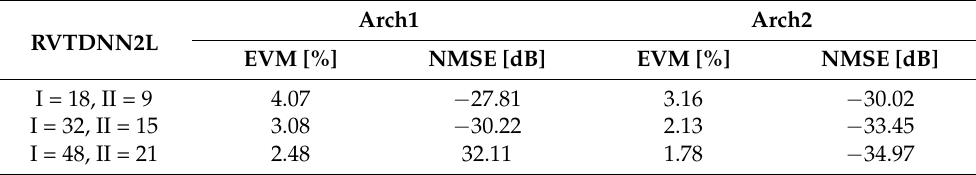
Figure 9. Power Spectral Density of the MU FC HBF mMIMO — user 2. Table 4. Performance of RVTDNN2L DPD for 64 × 64 MU FC HBF MIMO system — user 1.